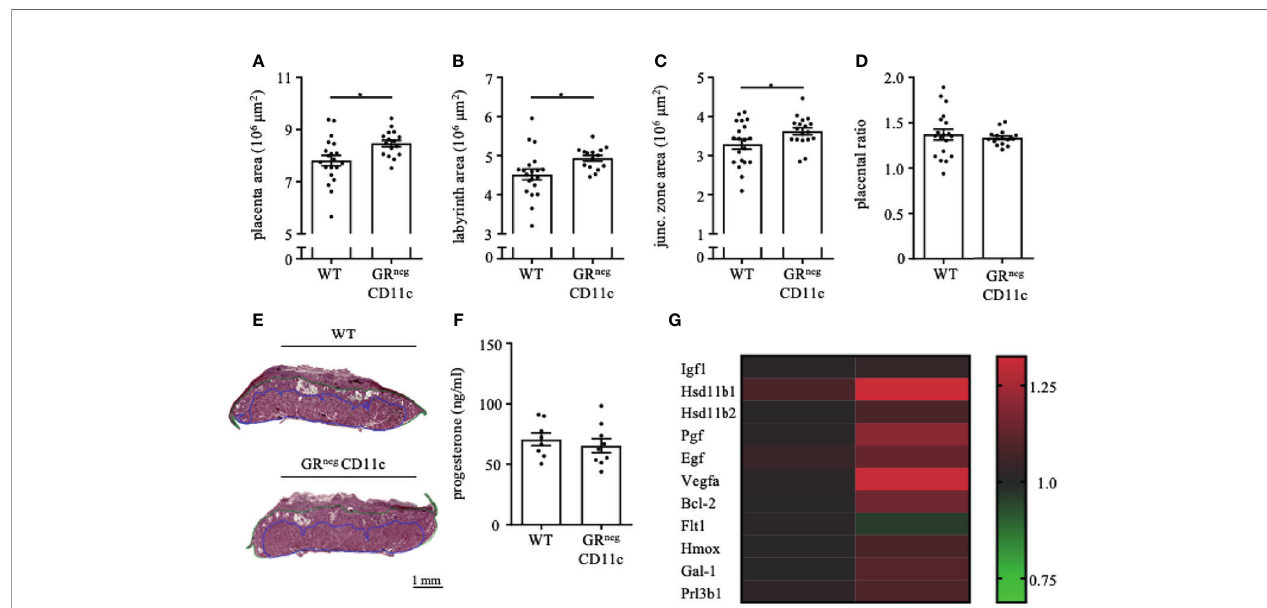
FIGURE 3 | Impaired Glucocorticoid-Responsiveness of CD11c + dendritic cells improves placenta function. WT and GRnegCD11c female mice were allogenically mated and placentas harvested on gestation day (gd) 13.5 were evaluated by Masson-Goldner trichrome staining allowing the differentiation of the labyrinth and junctional zone. Total placenta area (A) , area of the labyrinth (B) and the junctional zone (C) have been assessed and the placental ratio (D, labyrinth/junctional zone) was calculated. (E) Representative photomicrographs illustrating mid-sagittal sections of gd 13.5 placental tissue from WT (top) and GRnegCD11c (bottom) mothers, black line in the picture denotes 1mm, blue lines encircle the labyrinth, green lines surround the junctional zone. (F) Plasma progesterone levels of WT and GRnegCD11c female mice on gd 13.5 as analyzed by ELISA. Scatter-bar-plots represent mean ± SEM, Student ’ s t test, *p ≤ 0.05. Each dot in the scatter plot represents a single placenta (A – D) or a single animal (F) , respectively. (G) Heatmap summarizing the placental expression of insulin like growth factor 1 (Igf1), hydroxysteroid 11-beta dehydrogenase 1 and (Hsd11b1 and 2), placental growth factor (Pgf), epidermal growth factor (Egf), vascular endothelial growth factor A (Vegfa), B cell leukemia/lymphoma 2 (Bcl2), soluble FMS-like tyrosine kinase 1 (sFlt1), heme oxygenase 1 (Hmox1), Galectin-1 (Gal-1), and placental lactogen II (Prl3b1) calculated by qPCR from gd 13.5 placentas. The fold change over WT control expression was calculated using RNA polymerase II subunit A (Polr2a) and ubiquitin C (Ubc) as endogenous control and employing the dd Ct